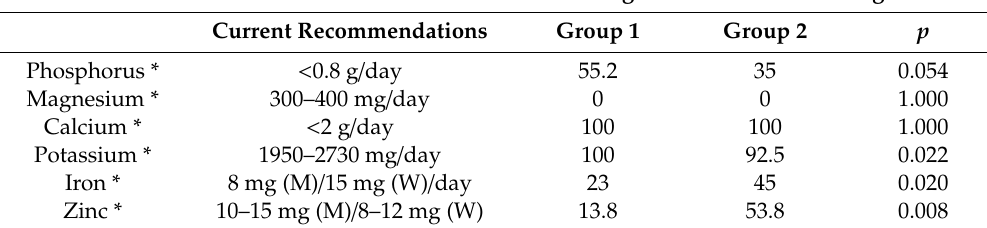
Table 6. Recommended daily dietary intake (mean ± SD) of minerals and trace elements and percentage of patients within the target value, according to the daily sodium intake (Group 1: < 1500 mg; Group 2: ≥ 1500 mg). M, men; W, women.